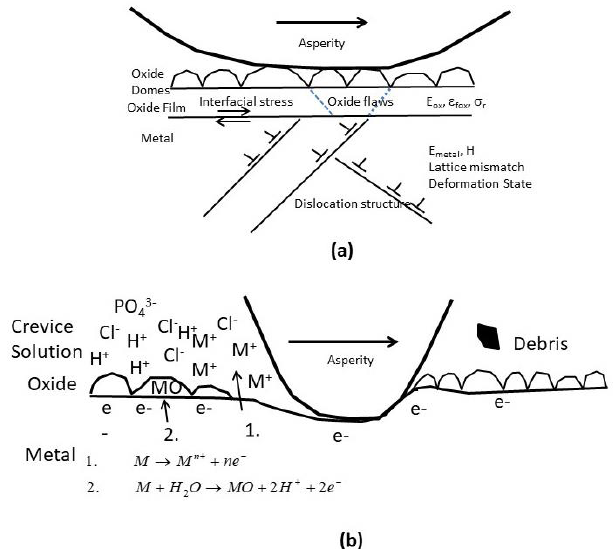
Figure 30. Schematics of asperity-oxide-metal interfaces showing some of the factors associated with fretting corrosion processes [40]. ( a ) The surface oxide film in contact with an opposing asperity has a structure that typically consists of an oxide dome on an oxide film with its characteristic modulus of elasticity, fracture strain and residual stresses. A lattice mismatch between oxide and metal gives rise to residual stresses and interfacial stresses as does the asperity interaction. The metal substrate structure and chemistry are also important, for example, the dislocation density. ( b ) An asperity moving across a metal-oxide surface where contact stresses and motion scrape oxide from the metal surface, generating oxide debris. Behind the moving asperity, electrochemical reactions regenerate the oxide and dissolve metal cations into the crevice solution. Hydrogen ion generation and anions migrating into the crevice to maintain charge neutrality cause local pH drop [40]. Reprinted with permission from Springer Nature.